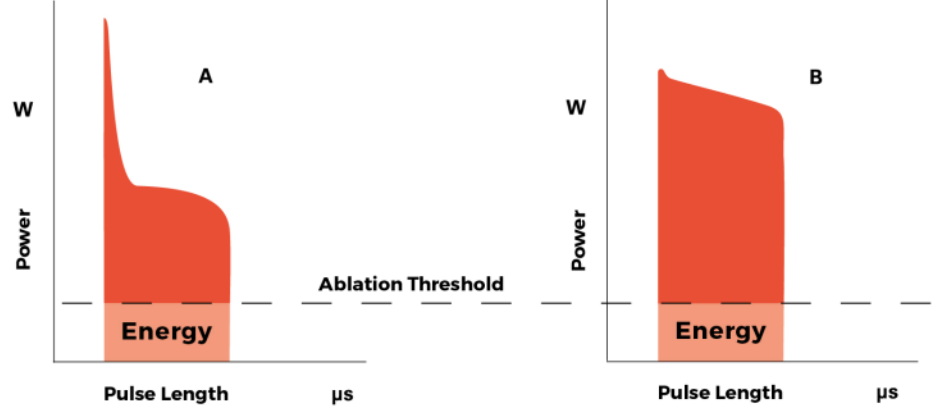
Figure 1. ( A ) DC- (Direct Current) excited CO 2 laser single pulse (superpulsed emission). ( B ) RF- (radiofrequency) excited CO 2 laser single pulse (ultrapulsed emission). In RF-excited CO 2 laser source ( B ), the same pulse length produces more energy over the ablation threshold, compared to the DC-excited one ( A ). (courtesy of DEKA-M.E.L.A., Calenzano, Italy).